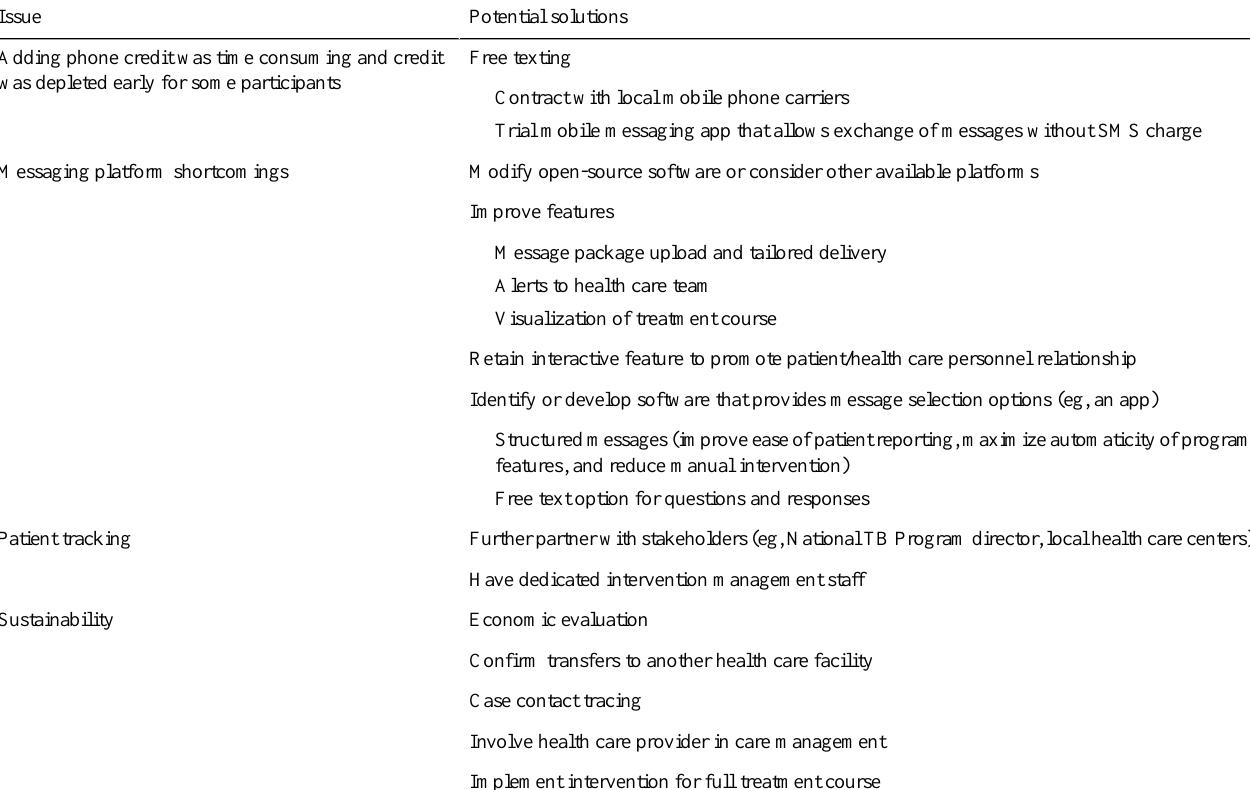
Table 2. Identified implementation issues and potential